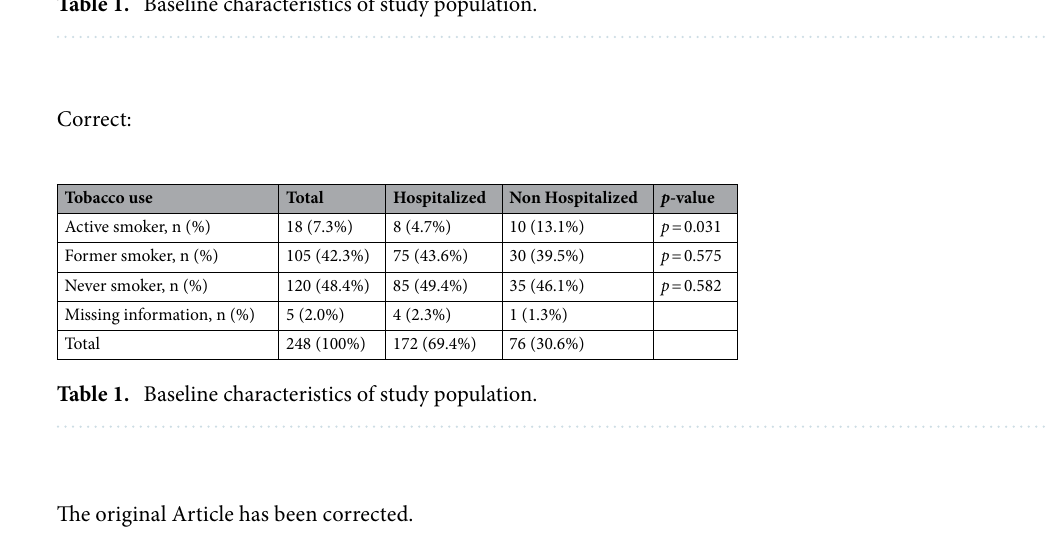
Table 1. Baseline characteristics of study population.